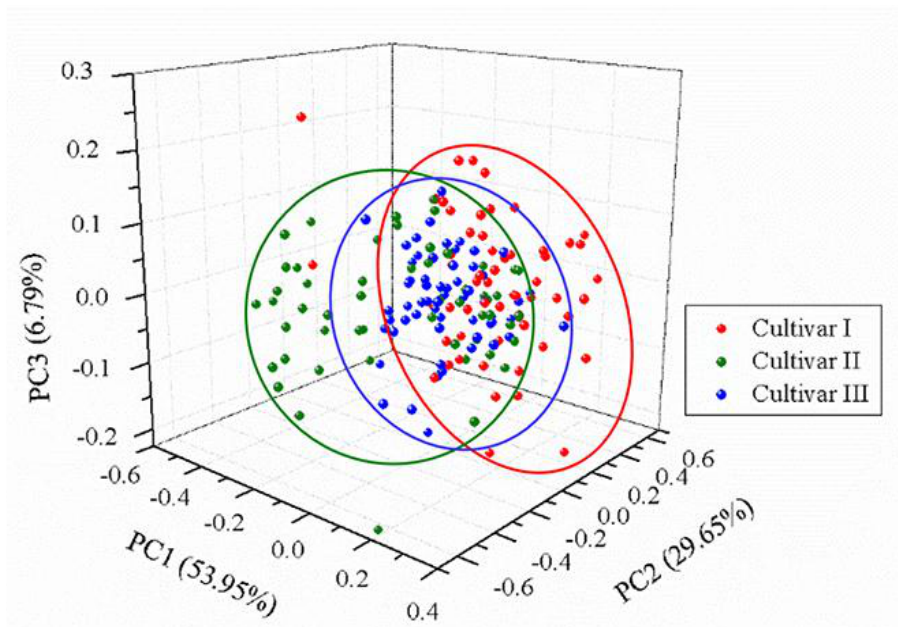
Figure 3. 3D score scatter plot of three cultivars based on the first three principal components (PCs). The total variance in the data explained by the first three PCs was 90.39% (53.95%, 29.65%, and 6.79% of PC1, PC2, and PC3, respectively).